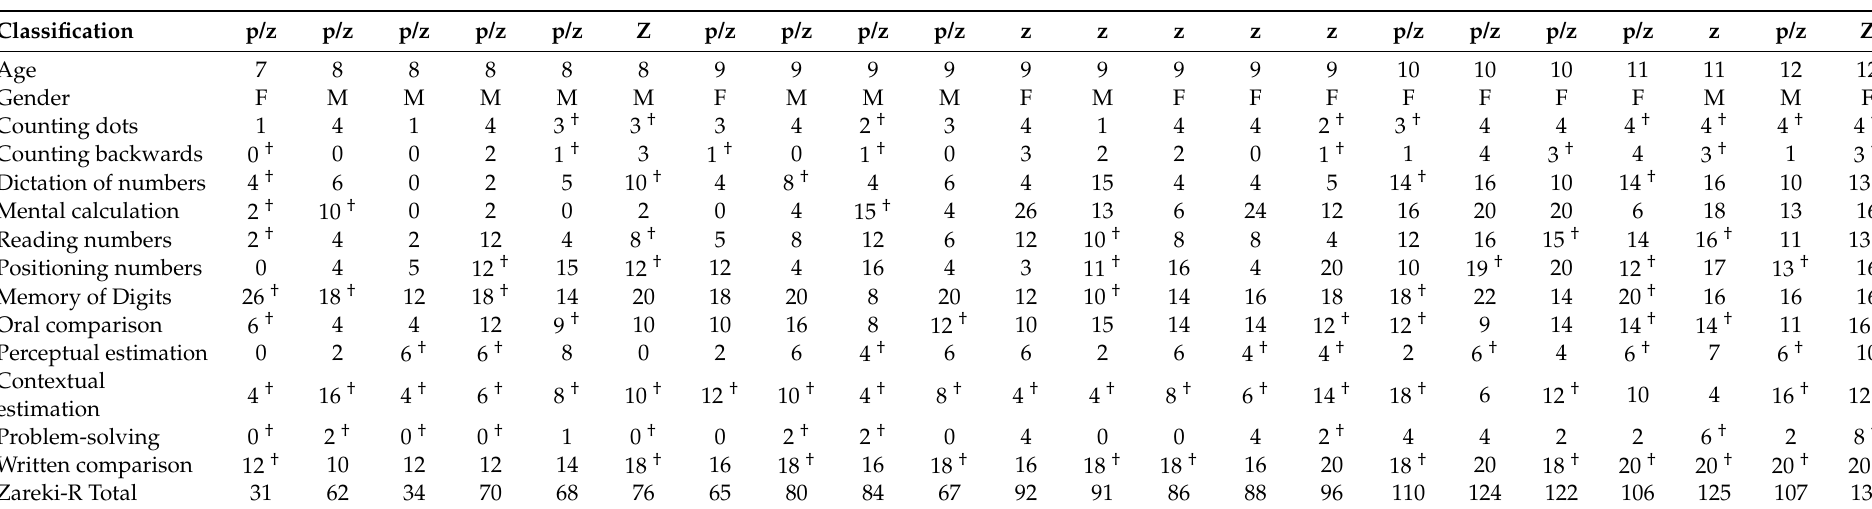
Table A2. Individual row scores on Zareki-R of children diagnosed with DD on the 5th percentile and/or on